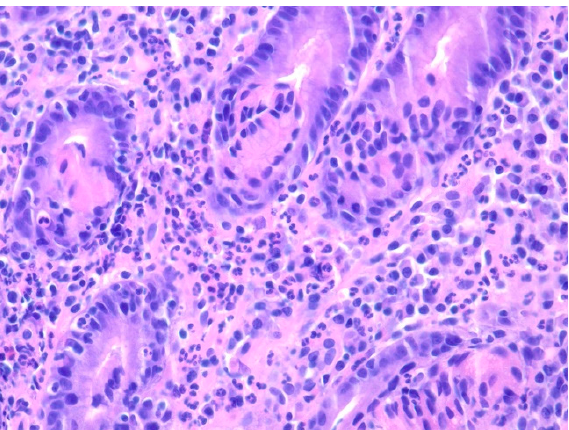
Figure 12. Diffuse proliferation of large pleomorphic lymphoid cells with prominent nucleoli with some nuclei being lobulatedThere is a background of small lymphocytes, plasma cells, and neutrophils within the gastric mucosa on Hematoxylin and eosin stain at 400× magnification.